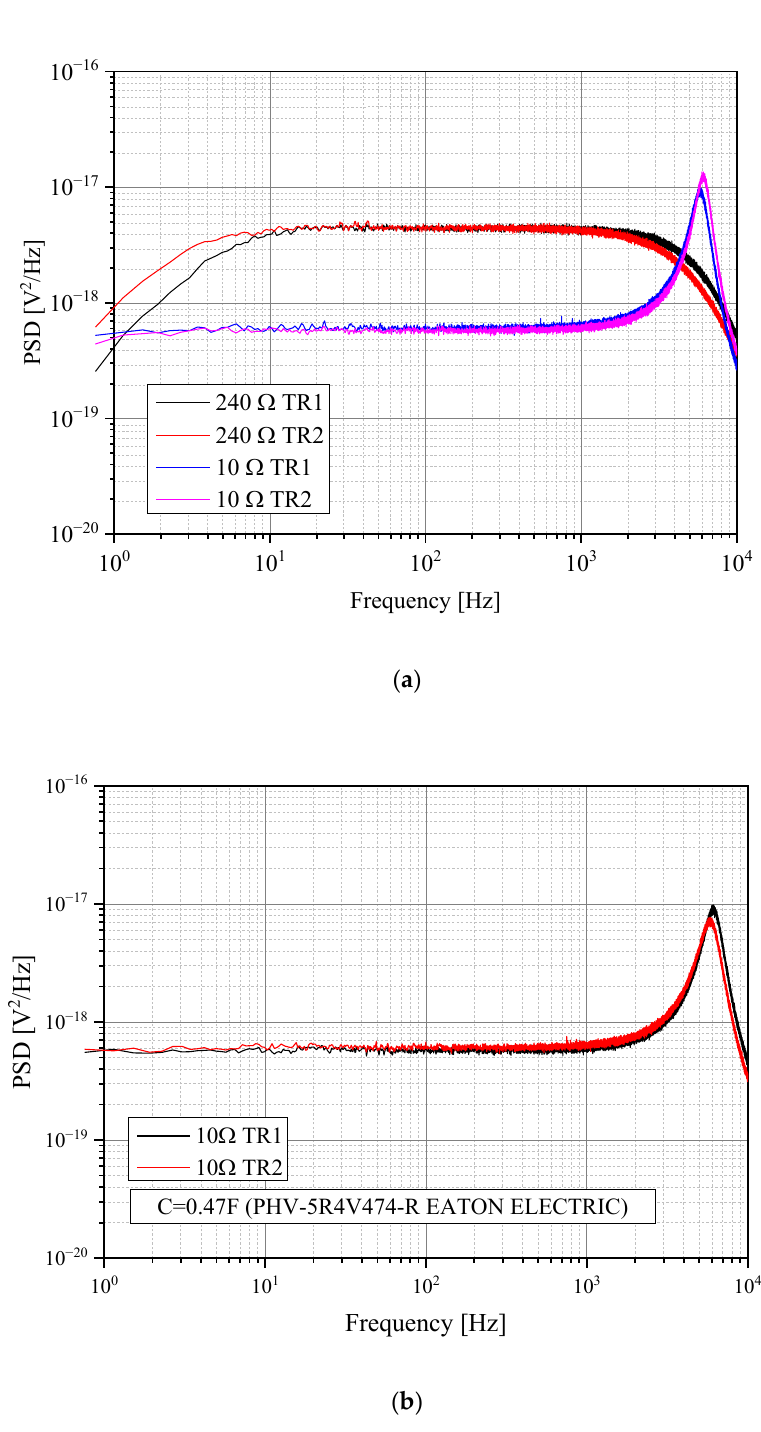
Figure 3. Noise measurements of different DUT resistances in configuration of bridge ( a ), position 1, and supercapacitor ( b ), position 2.